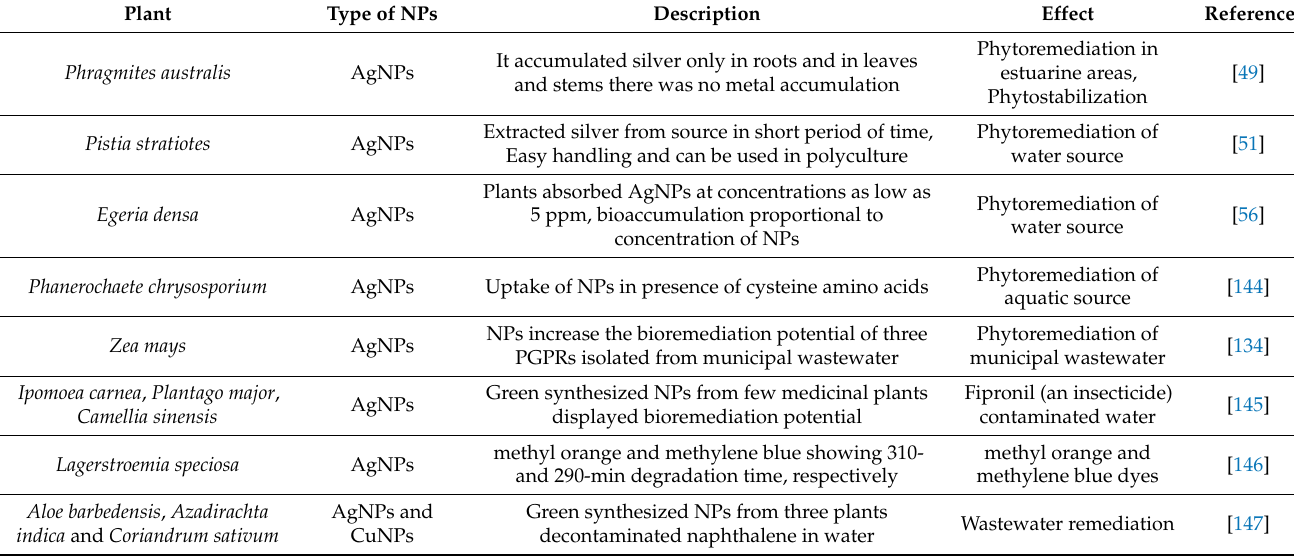
Table 3. Phytoremediation of